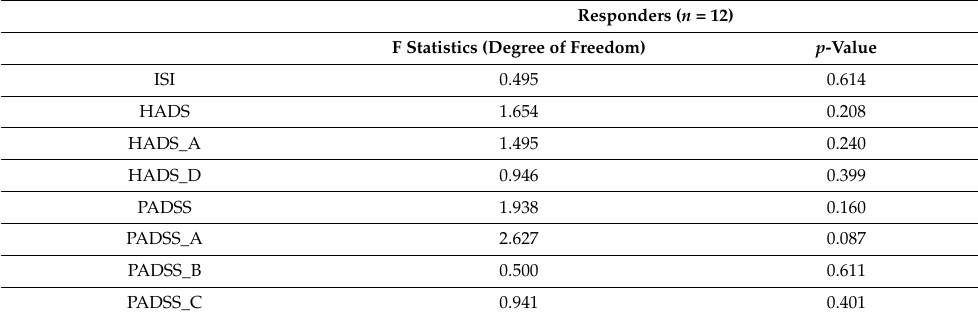
Table 3. Results of ANOVA test between pre-treatment (before CBT-NREMP intervention), post- treatment (after CBT-NREMP intervention) and the current follow-up (during lockdown) for scales of ISI, HADS and PADSS for responders ( n = 12).